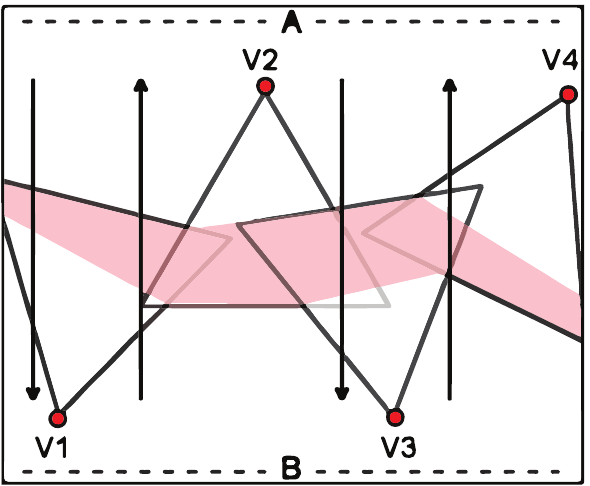
Figure 4. WVSN for barrier